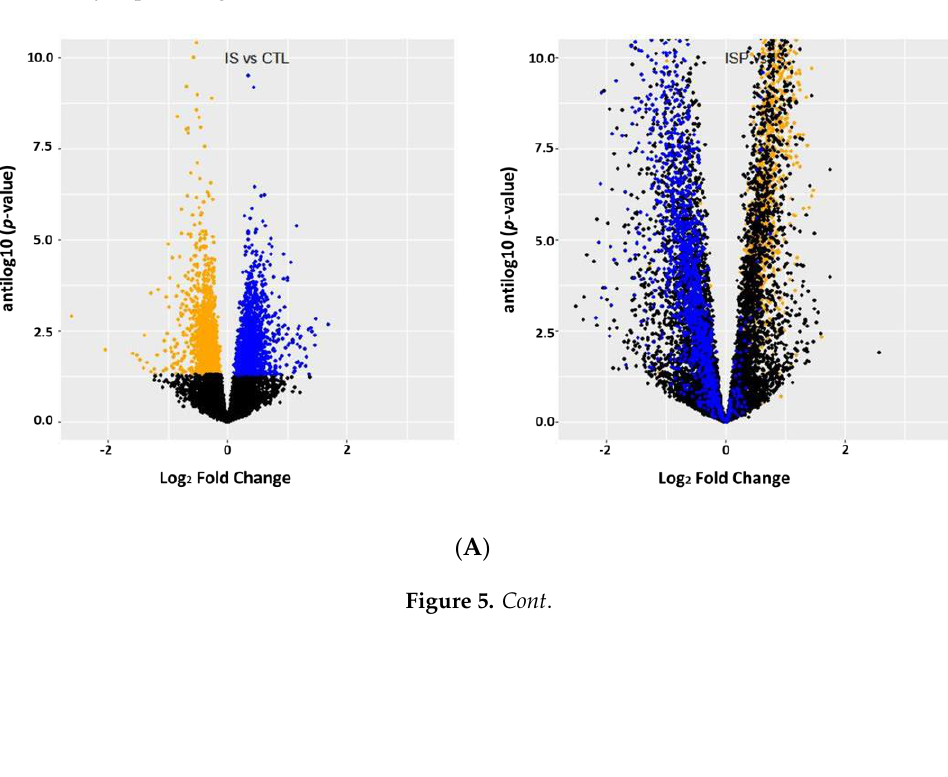
( B ) Figure 5. ( A ) Volcano plot of gene expression in adipocytes exposed to IS vs. control (CTL) (left panel) and IS+ pNaKtide (ISP) vs. IS expression (right panel) plotting antilog of unadjusted p -value on y-axis vs. log 2 Fold Change on x-axis. Genes downregulated (unadjusted p -value of <0.1) by IS colored orange and genes upregulated (unadjusted p -value of <0.1) by IS colored blue. We note that addition of pNaKtide expression moved upregulated genes down and downregulated genes up. ( B ) Gene Ontology summary of over representation analysis (ORA) in IS treated murine adipocytes. Gene ontology annotation of biological processes, cellular components and molecular function categories.